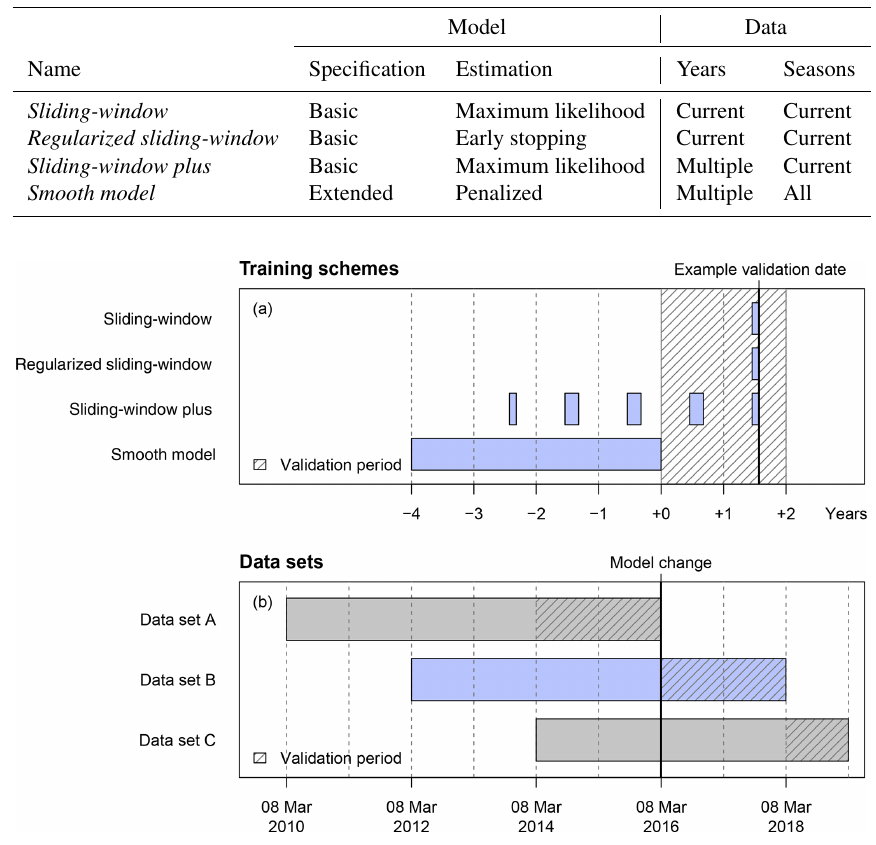
Figure 2. (a) Illustrative example of how the training data sets are composed for the four different time-adaptive training schemes. (b) Schematic overview of the training and validation data sets employed in this study with regard to the change in the horizontal reso- lution of the ECMWF EPS on 8 March 2016 (cycle 41r2). For training, up to 4 years of data are used in all data sets; for validation, 2 years of data are used for data sets A and B, and 1 year for data set